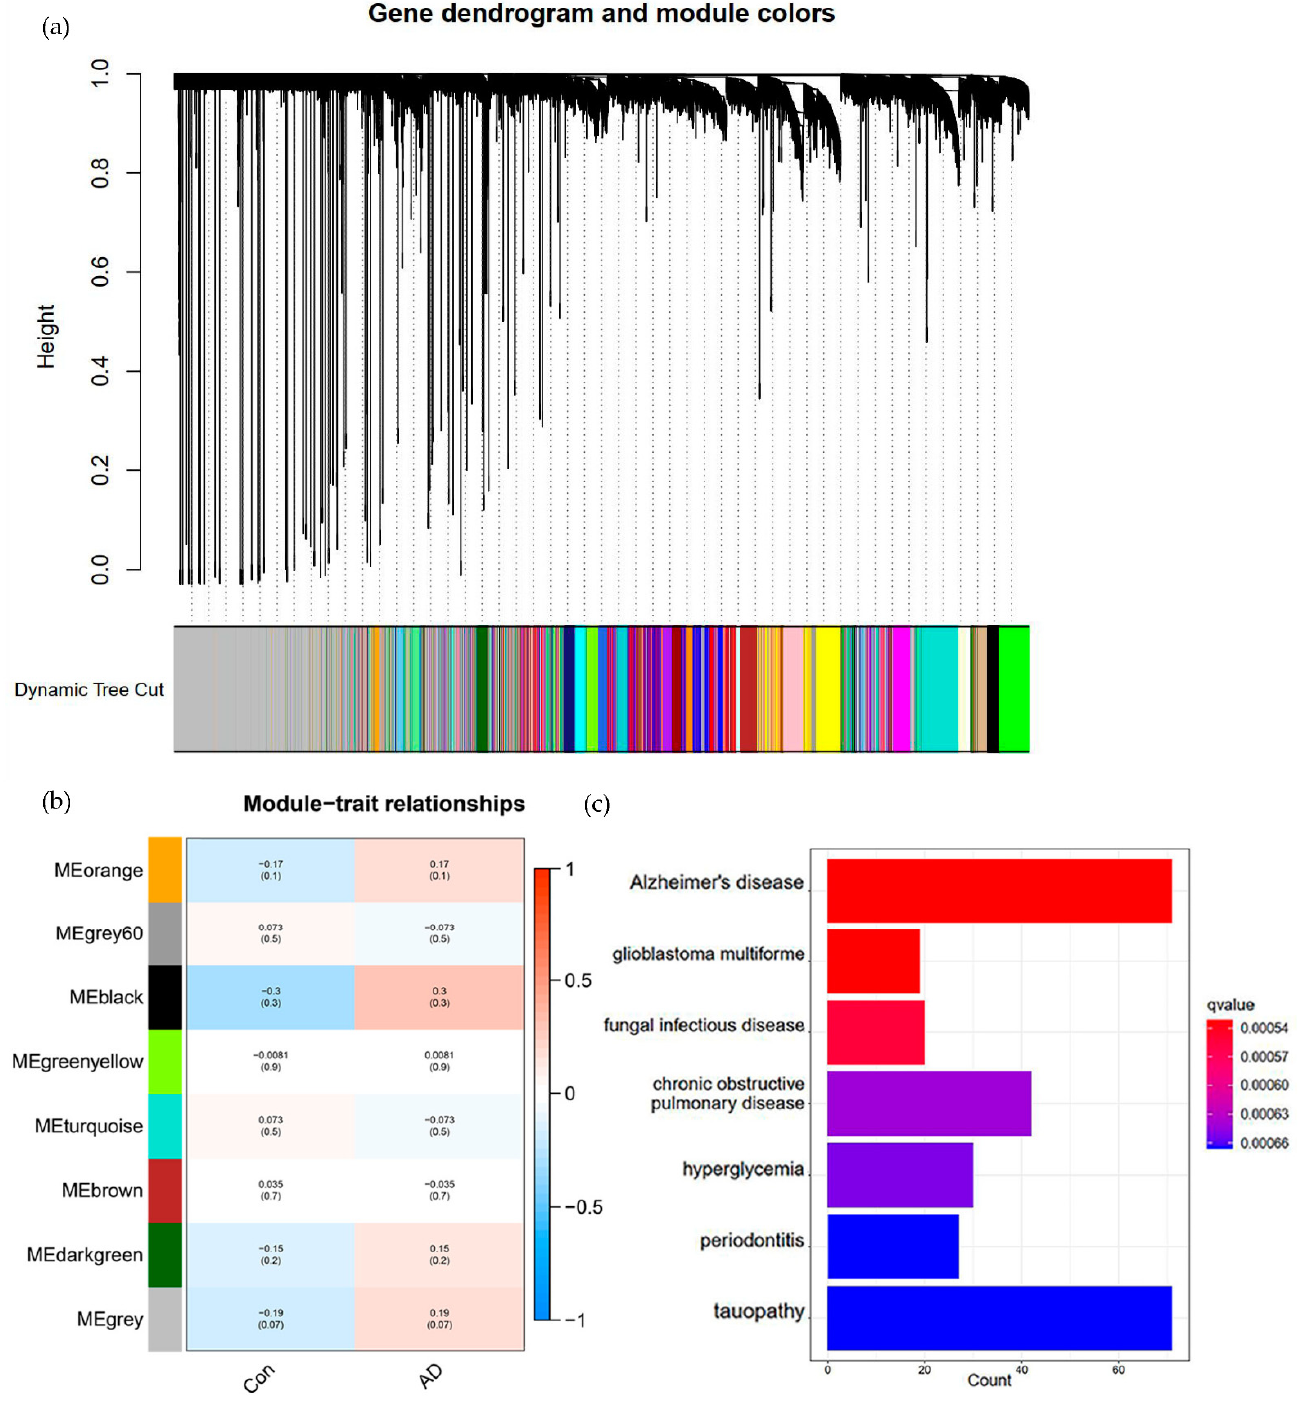
Figure 4. Extraction and verification of the black module, based on the WGNCA results. ( a ) Dendrogram clustered based on a dissimilarity measure (1 ‐ TOM). The black module was identified as an AD microglial ‐ related module. ( b ) Module ‐ trait relationships of bulkRNA ‐ seq data. Each row corresponds to a module eigengene, and each column to a trait. Each cell contains the corresponding correlation and p ‐ value. Blue to red indicates a negative to positive correlation; the range is from − 1 to 1. ( c ) Results of DO enrichment analysis of the black module, with the number of genes in the pathway on the horizontal axis and the list of pathways on the vertical axis, with the q ‐ value (adjusted p ‐ value) indicated in blue to red.